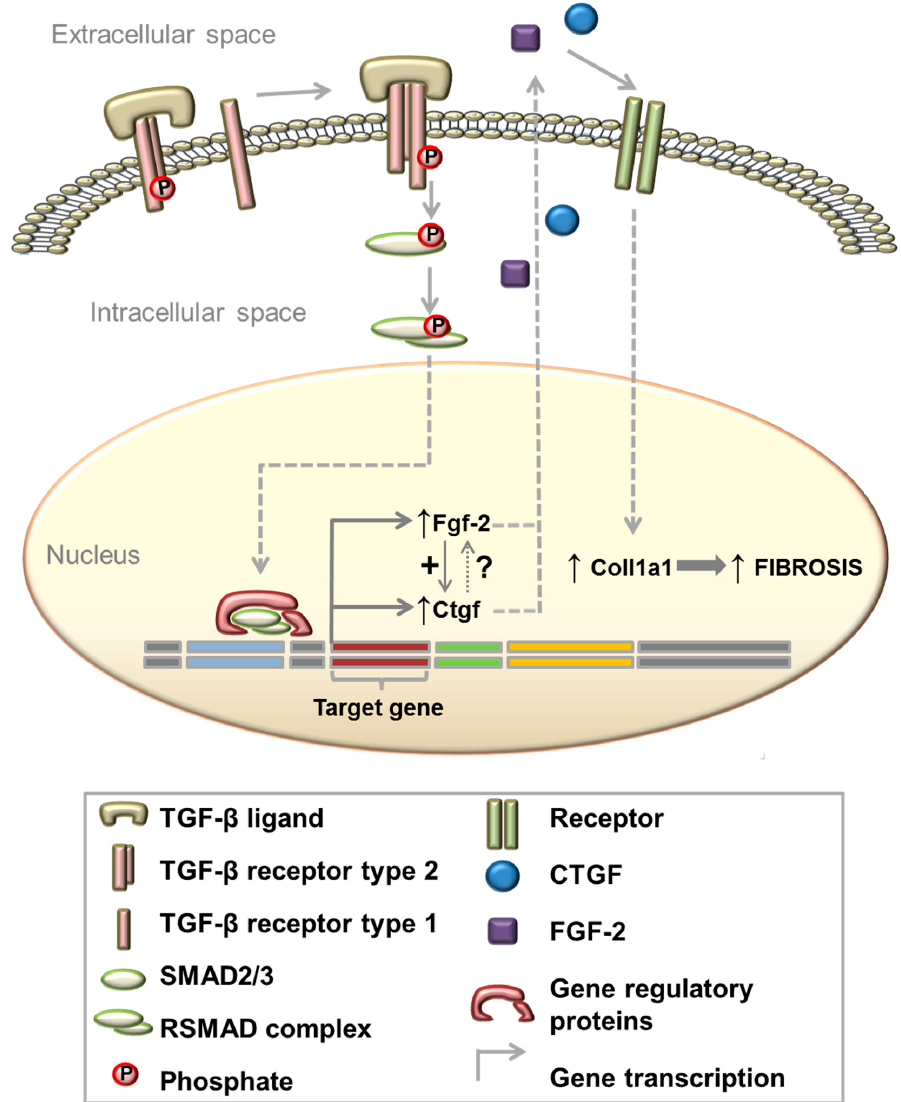
Figure 7. Schematic illustration of a proposed mechanism of how TGF- β regulates Col1a1 mRNA expression. TGF- β binds to its receptors and activates downstream SMAD2/3 signalling. Subsequently, R-SMAD complexes translocate into the nucleus to regulate mRNA expression of growth factors such as Ctgf and Fgf-2 . CTGF and FGF-2 proteins are secreted by the muscle cell and subsequently induce Col1a1 expression via autocrine or paracrine signalling. Furthermore, expression levels of Fgf-2 and Ctgf are dependent on each